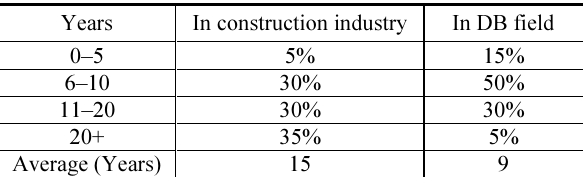
Table 2. Respondent classifications by years in the construc-